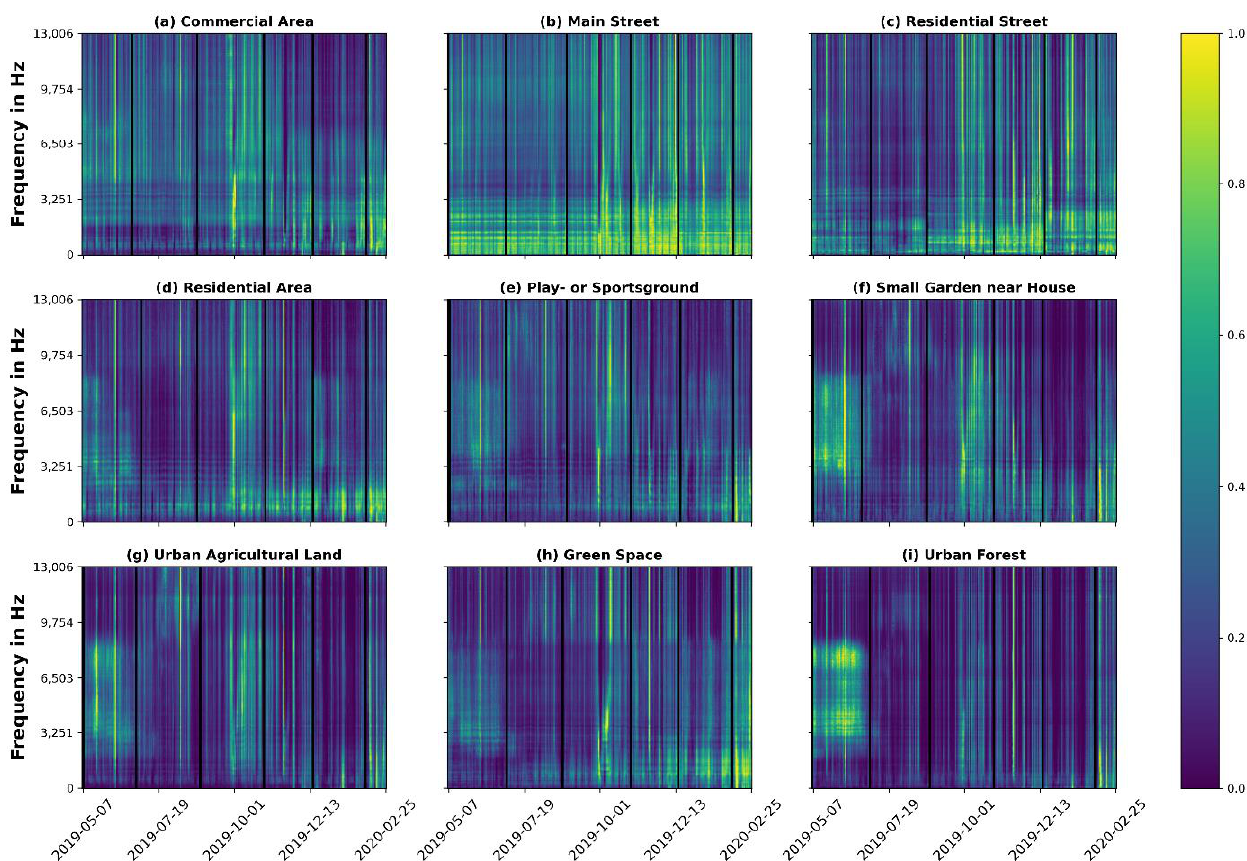
Figure 4. Normalised Spectrograms for all LUTs ( a – i ). A mean power spectrum was calculated for all recordings per date/device. Subsequently, for each frequency bin (i.e., time series), the power was normalised so that the values correspond to the relative power of the frequency to itself. Thus, one is the maximum measured power and zero is the minimum measured power of the respective frequency bin. Black columns represent maintenance days, during which no recordings were made.